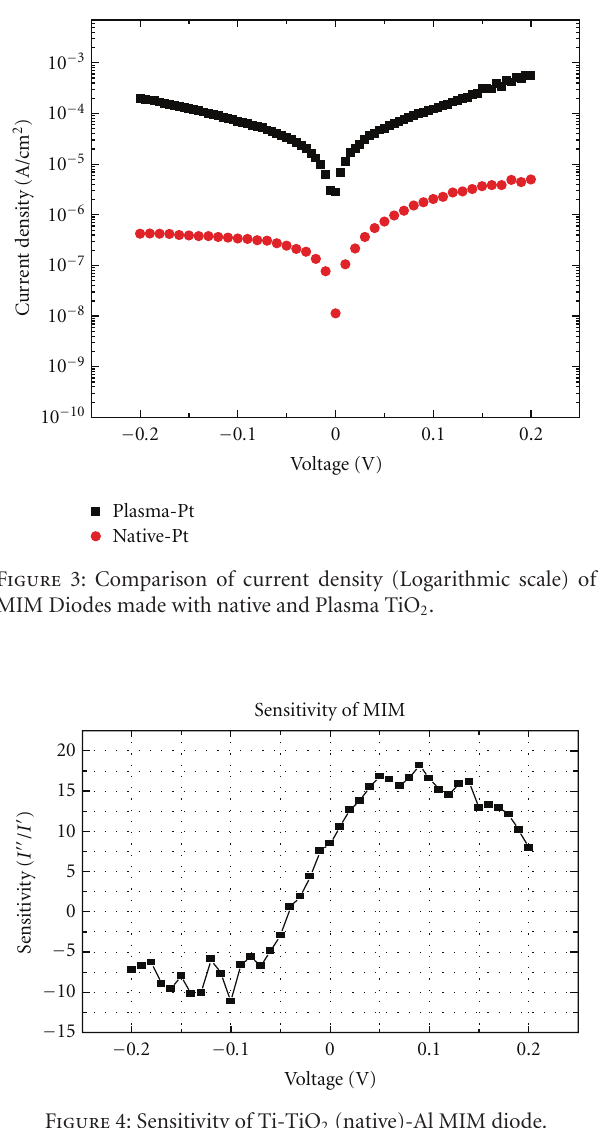
Figure 4: Sensitivity of Ti-TiO 2 (native)-Al MIM diode.